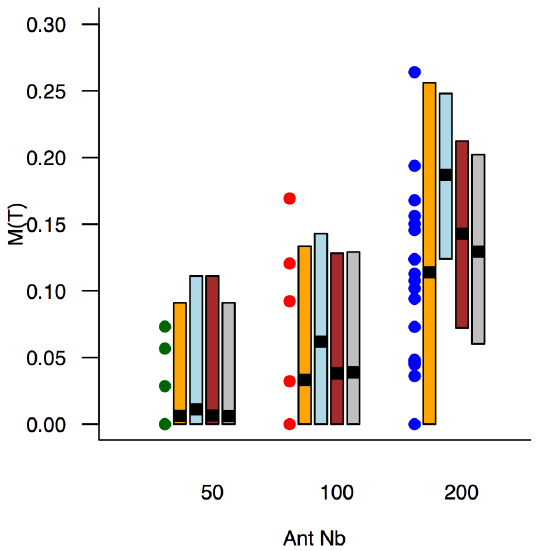
Figure 5. The impact of colony size on the final topology is shown by the meshedness M ( t ) as a function of the number of workers A . Symbols: experimental values for the three group sizes (green: A=50, red: A=100, blue: A=200, same colours as in Fig. S4). Orange boxes: means and 95% CI predicted by the model using the complete collection of parameters sets. Blue boxes: means and 95% CI predicted by the model using the set of averaged parameters. Brown boxes: means and 95% CI predicted by the model using averaged branching rates, and activity parameters corresponding to the average activity. Gray boxes: 95% CI predicted by the simplified model using the same parameters.